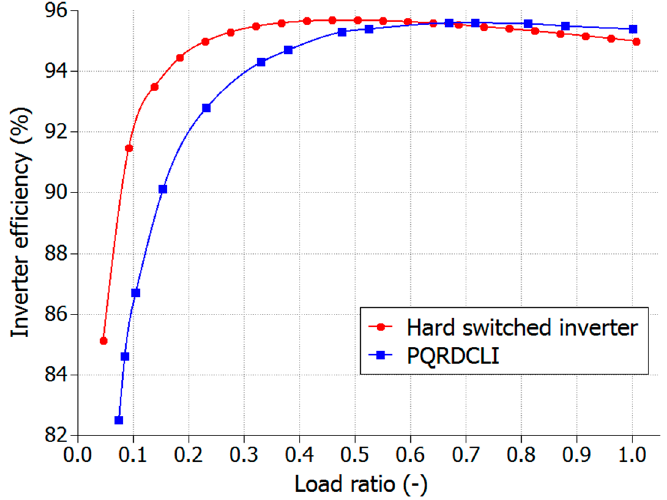
Figure 20. Measured relationship between efficiency and load ratio of hard-switched inverter and PQRDCLI.